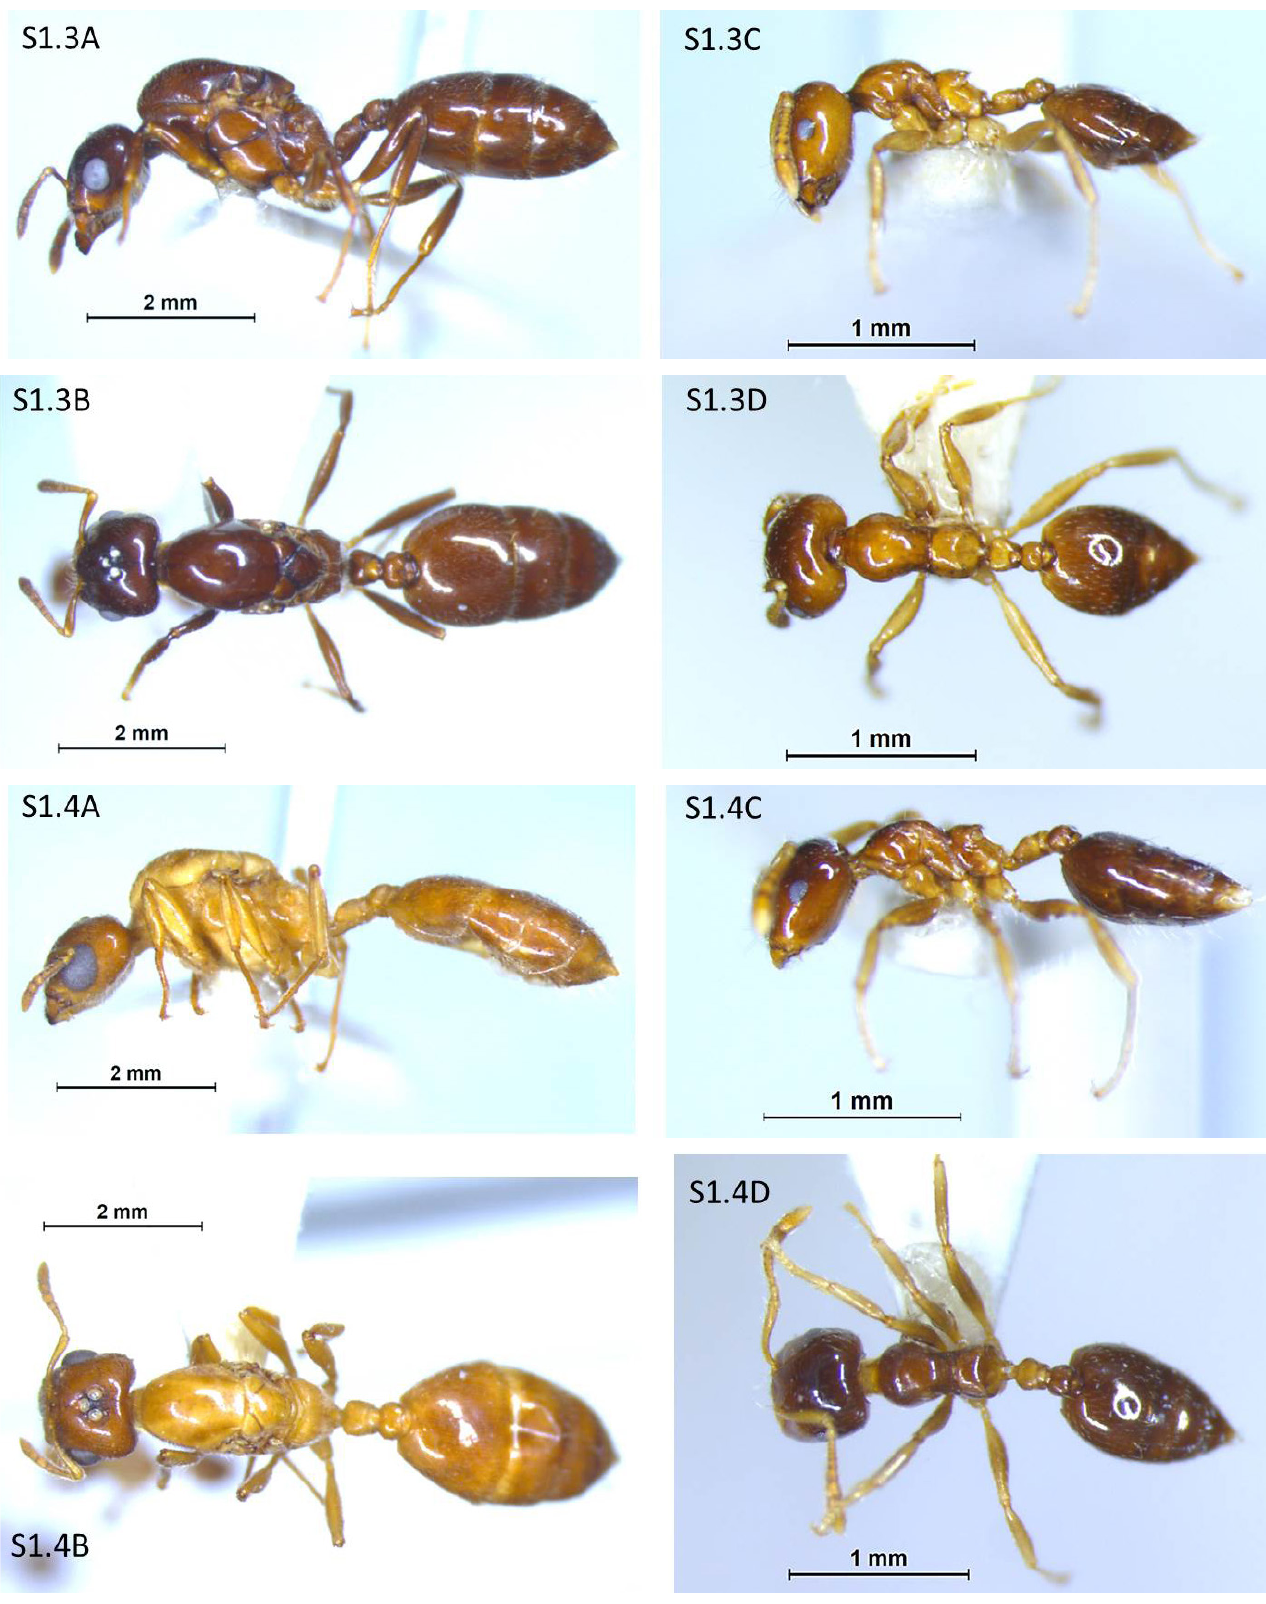
Fig S1.3A-D: C. hullettii, leg. H. Feldhaar, 9.2.2000, Genting Highlands (Pen. Malaysia) from Macaranga hullettii; S1.3A: lateral view queen, S1.3B dorsal view queen, S1.3C lateral view worker, S1.3D dorsal view worker. Fig S1.4A-D: C. captiosa , leg. A. Meenken, 7.9.2002, Poring Hot Springs (Sabah) from Macaranga indistincta; S1.4A: lateral view queen, S1.4B dorsal view queen, S1.4C lateral view worker, S1.4D dorsal view